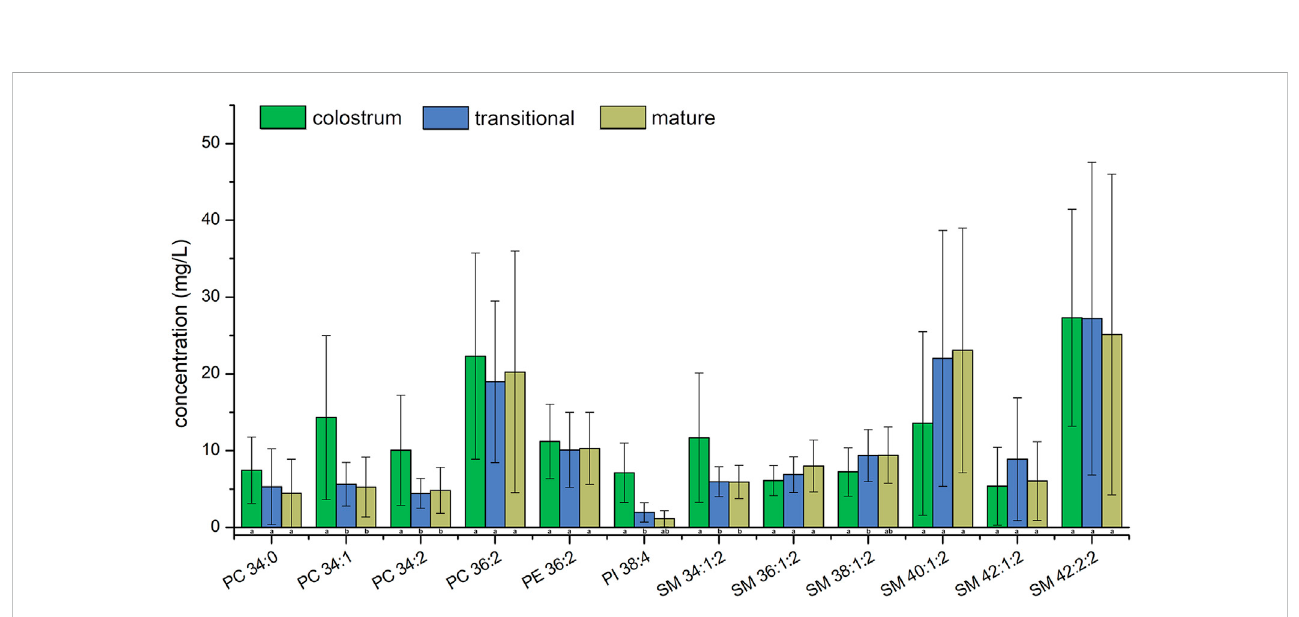
FIGURE 5 Average concentrations of top ten human milk phospholipids at different lactation